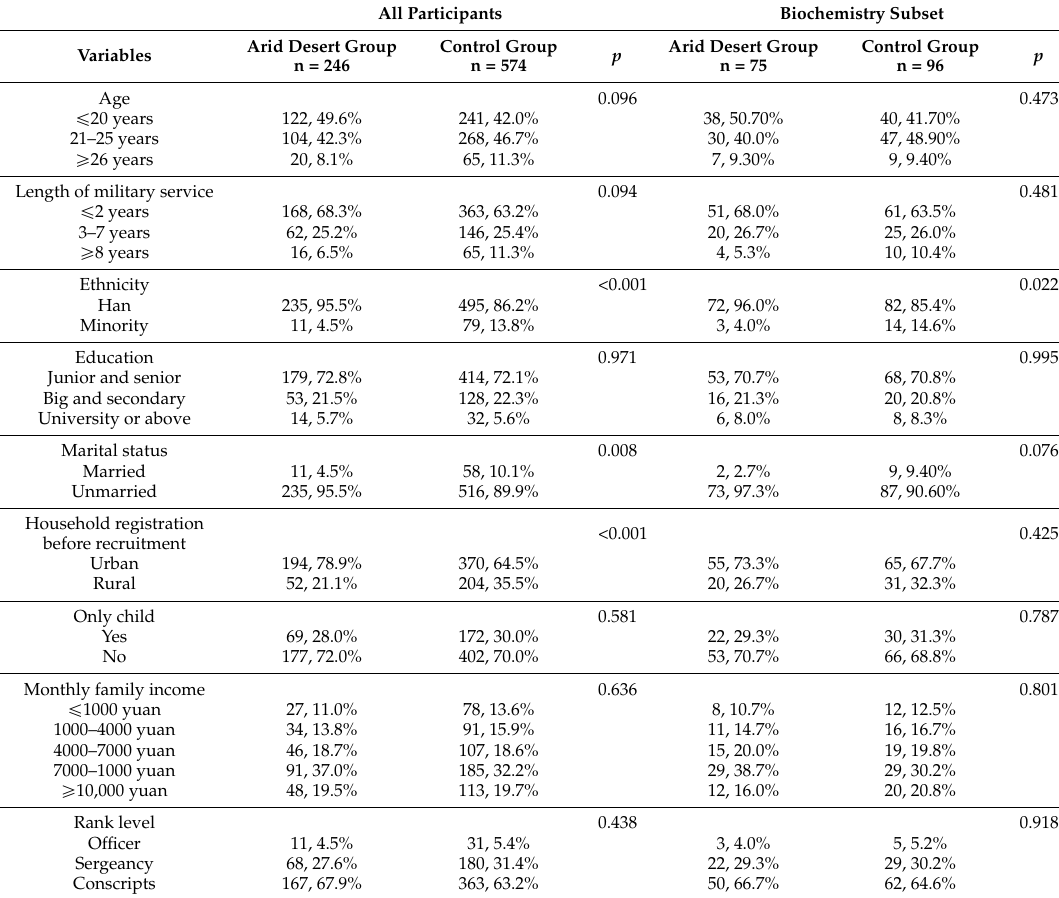
Table 1. Characteristics of the participants.